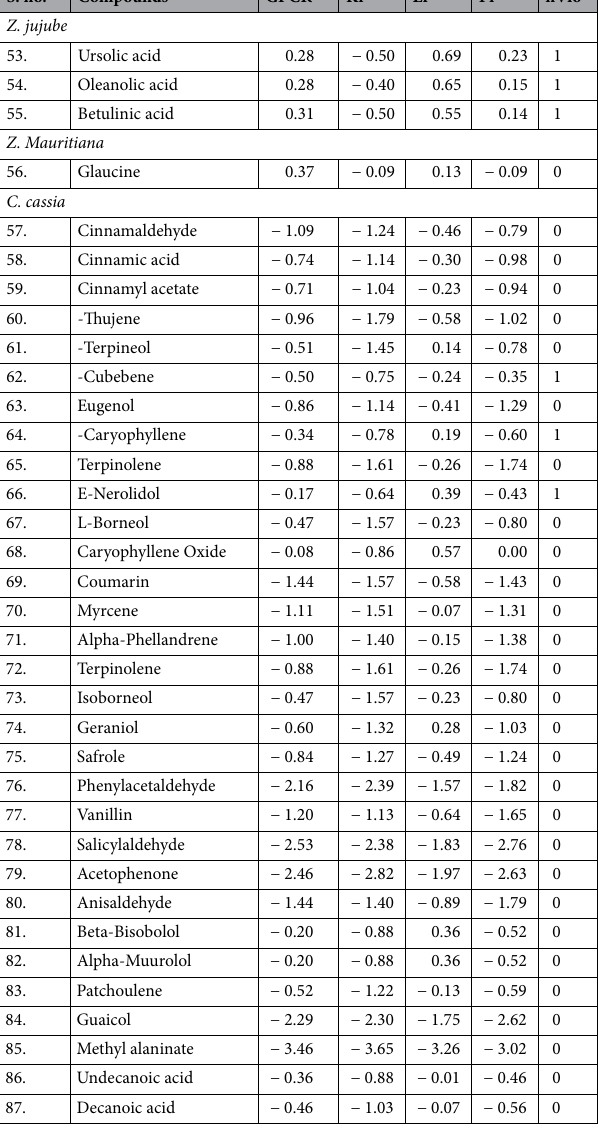
Table 4. Pharmacological features of the retrieved